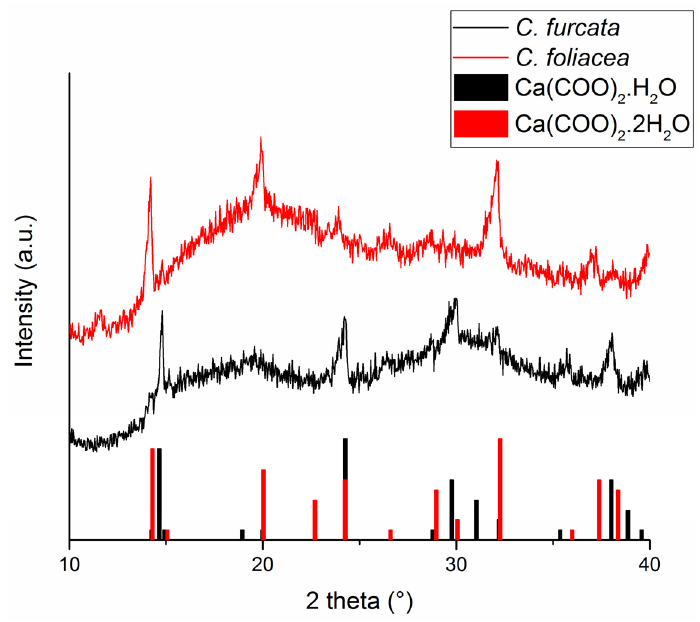
Figure 6. XRD pattern of the Ca-containing C. furcata ( black pattern ) and C. foliacea ( red pattern ) and corresponding intensities of the identified CaOX species according to JCPDS-PDF2 database (black line—35-0914, red lines—04-0702). The corresponding phases and formulas are provided in the figure. range are assigned to the ν (C–O) stretching modes. Thus, both CaOX hydrate minerals, weddellite (CaC 2 O 4 ∙ 2H 2 O) in C. foliacea (Figure 7) and whewellite (CaC 2 O 4 ∙ H 2 O) in C. furcata (Figure 8), were identified in the lichens by